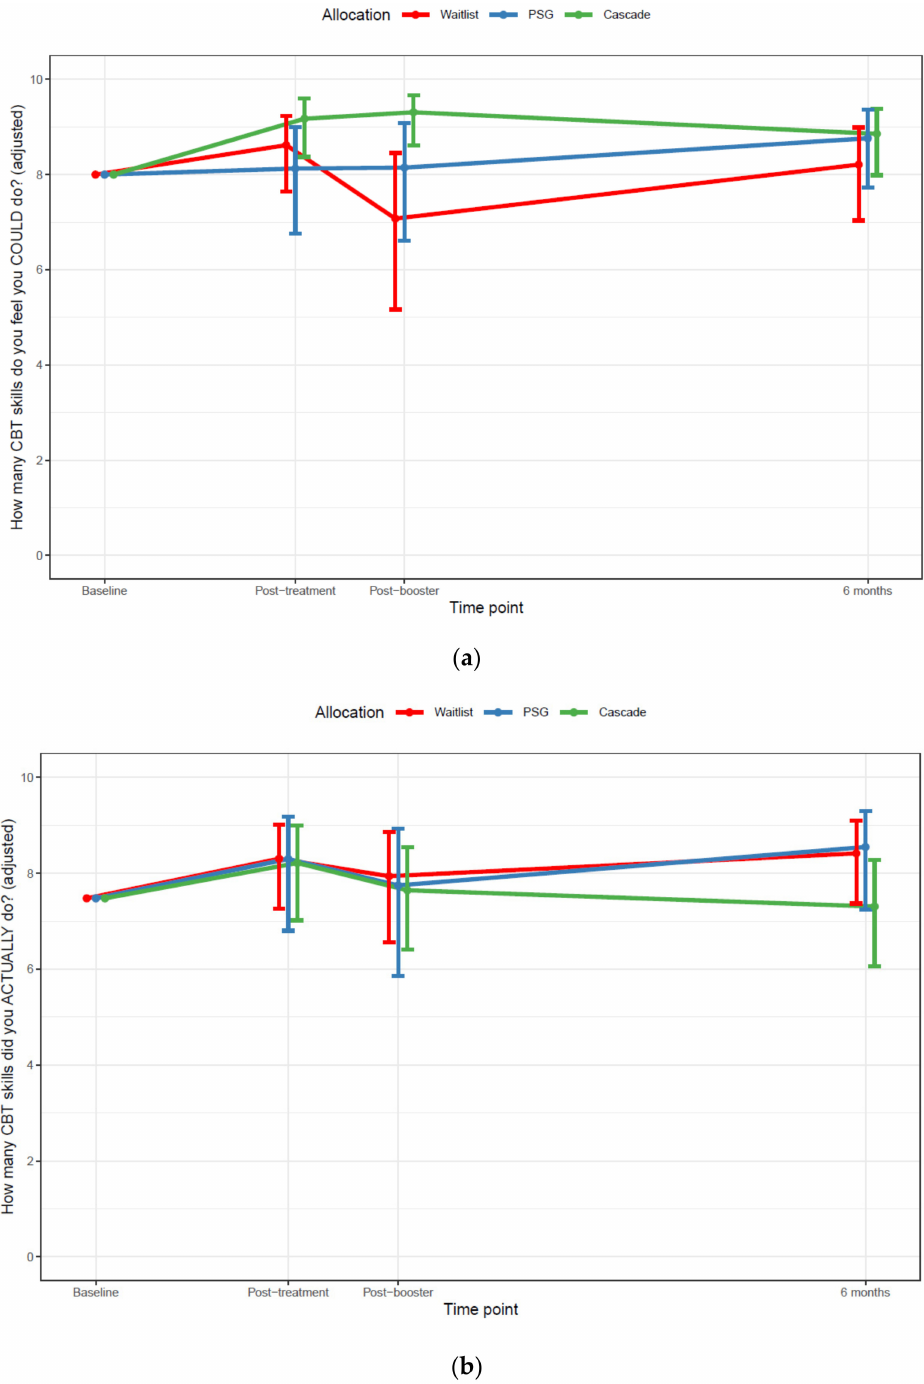
Figure 5. ( a ) Number of cognitive behavioral therapy skills participants felt confident to use, across groups and time points, adjusted for baseline (Q1) differences between groups ( b ) Number of cognitive behavioral therapy skills participants reported that they used within the past four weeks. Notes: The questionnaires at each time point included 10